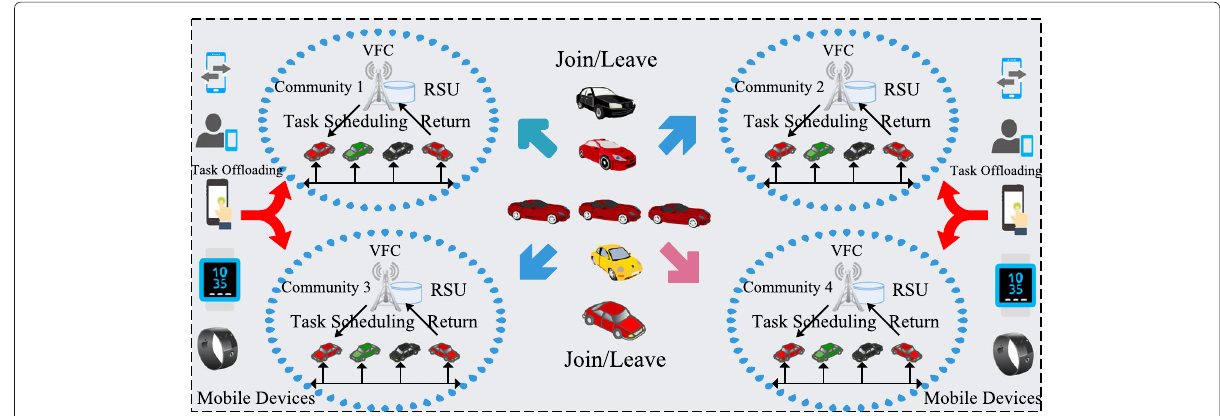
Fig. 1 Architecture of task scheduling in